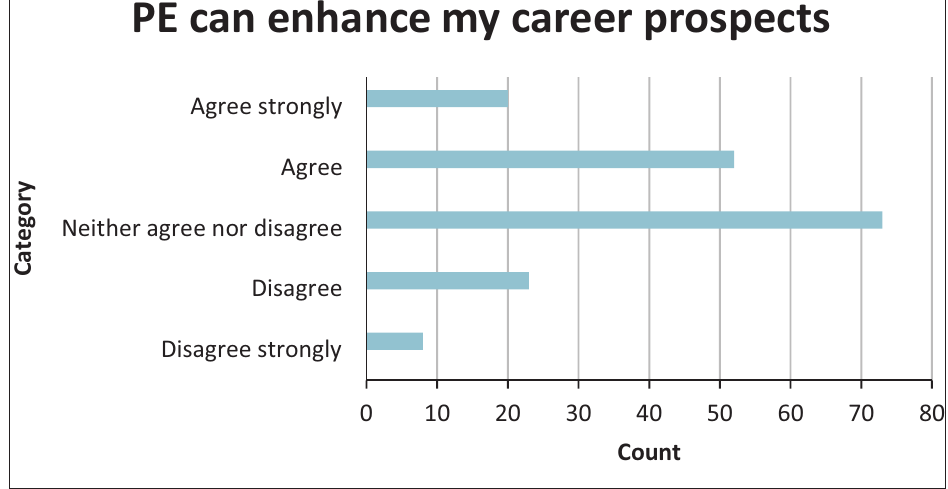
Fig. 4: PE is generally perceived as being benign or beneficial to individuals’ career paths. Source of data: National Survey on Public Engagement in Commercial Archaeology May- June 2013, n=181 (© Hilary Orange).